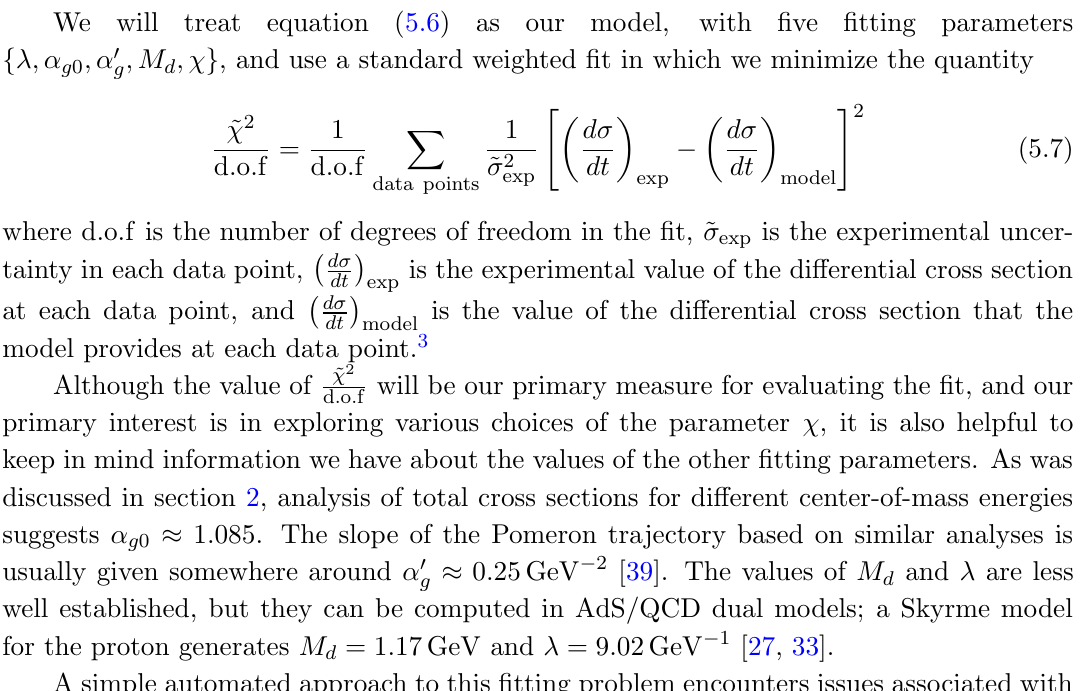
Figure 4 . A map of the minimum value of ~ (cid:31) 2 each value of (cid:31)